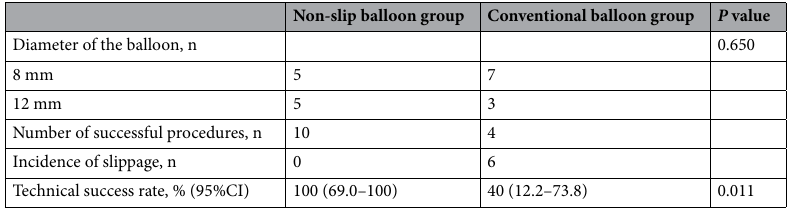
Table 3. Outcomes of the in vivo experiment. CI, confidence interval.